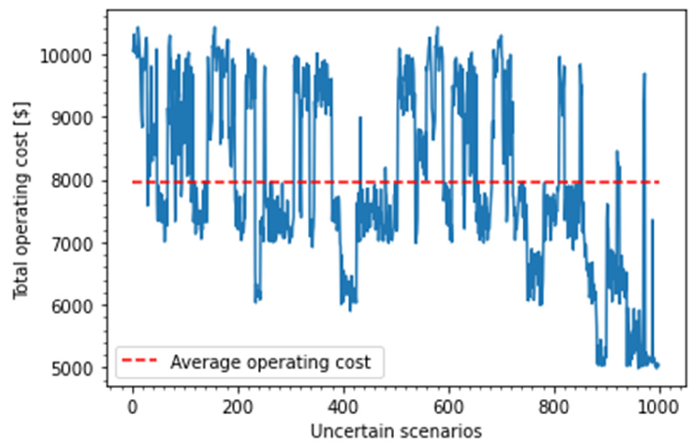
Figure 6. DCM’s operating cost with SP ‐ based MPC approach.